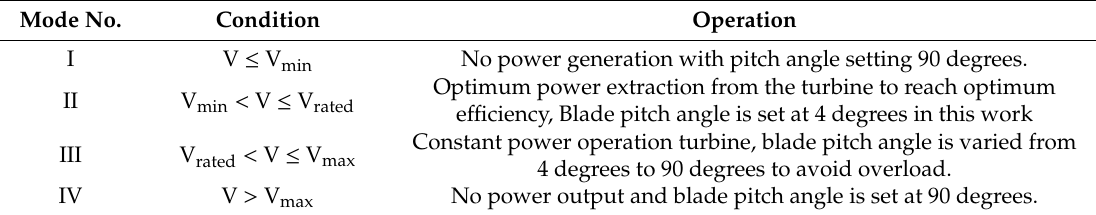
Figure 2. Tidal turbine modes of operation [24]. Table 1. Tidal turbine modes of operation [21].